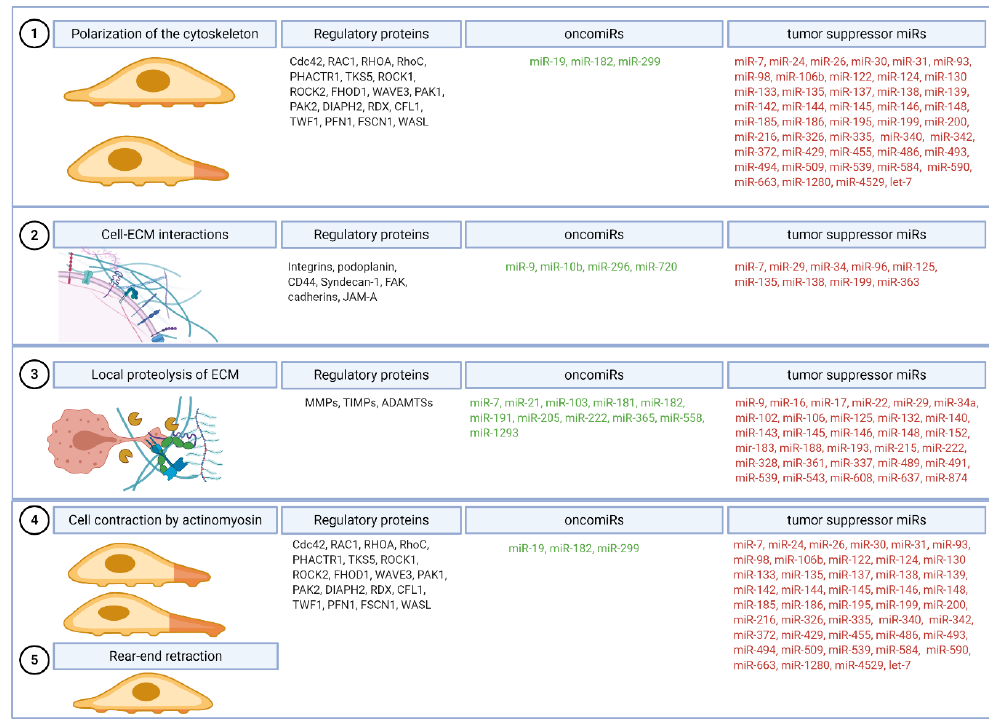
Figure 3. Stages of invasive cell migration. Five steps are required for successful tumor cell migration.